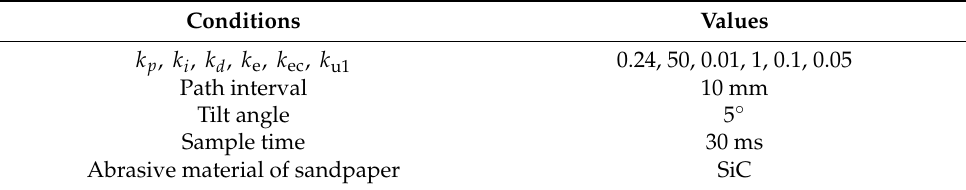
Table 4. Parameters setting in polishing process.